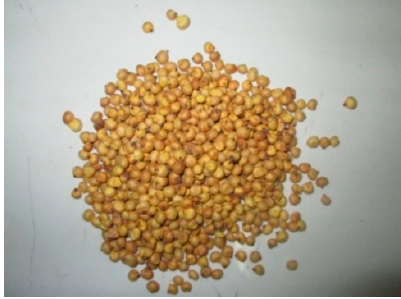
Figure 1. Safrari cultivar.